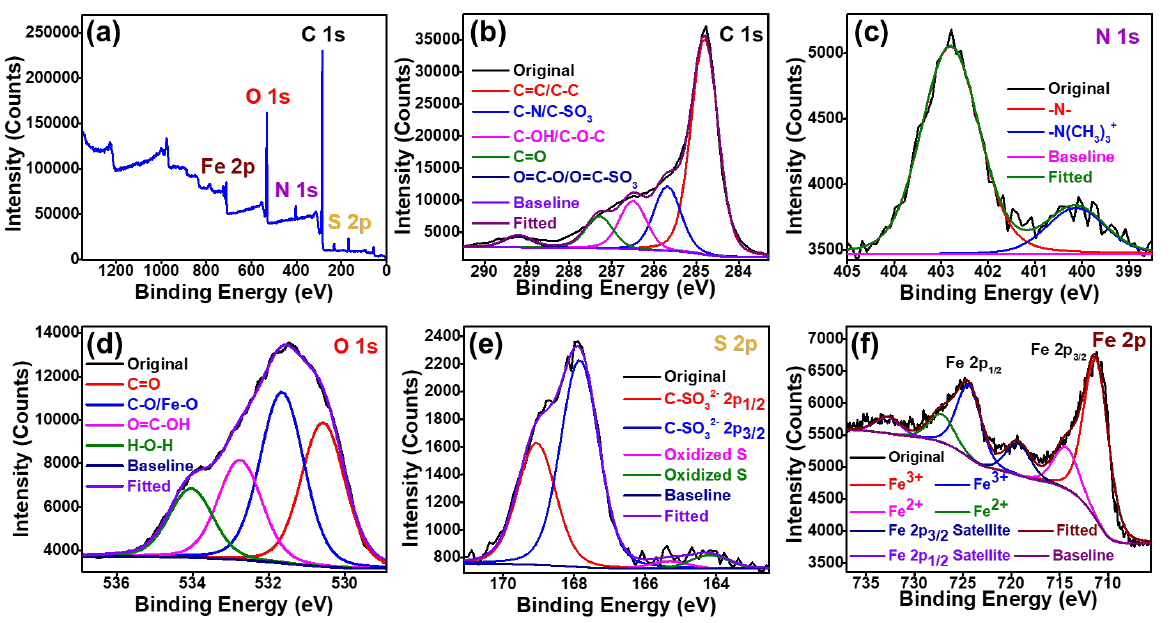
Figure 6. XPS spectra of GPSBI: ( a ) survey spectra, ( b ) C 1s, ( c ) N 1s, ( d ) O 1s, ( e ) S 2p, and ( f ) Fe